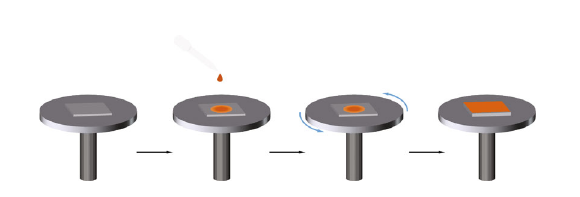
Figure 1: Schematic diagram of spin coating.